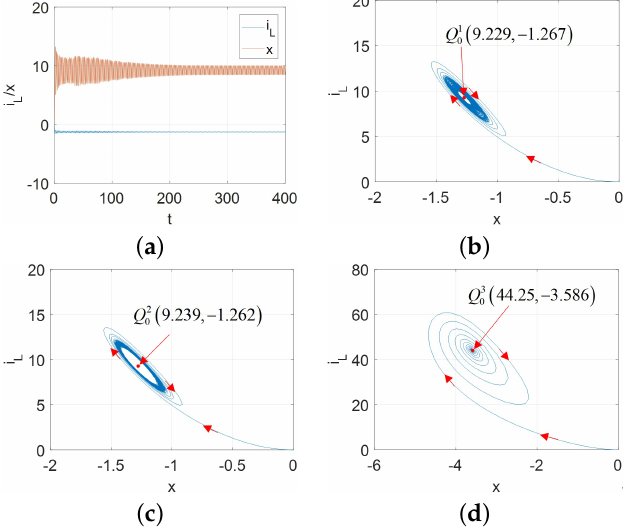
Figure 18. v (cid:101) [ 3.6,5.725 ] and initial condition [ x ( 0 ) , i L ( 0 )] = [ − 0.01,0 ] for A = A FS : ( a ) x ( t ) and i L ( t ) for v = 5.73 V; ( b ) stable limit cycle converges to Q 1 corresponding to the periodic waveforms for v = 5.72; ( d ) stable limit cycle converges to Q 3 –3.586) for v =